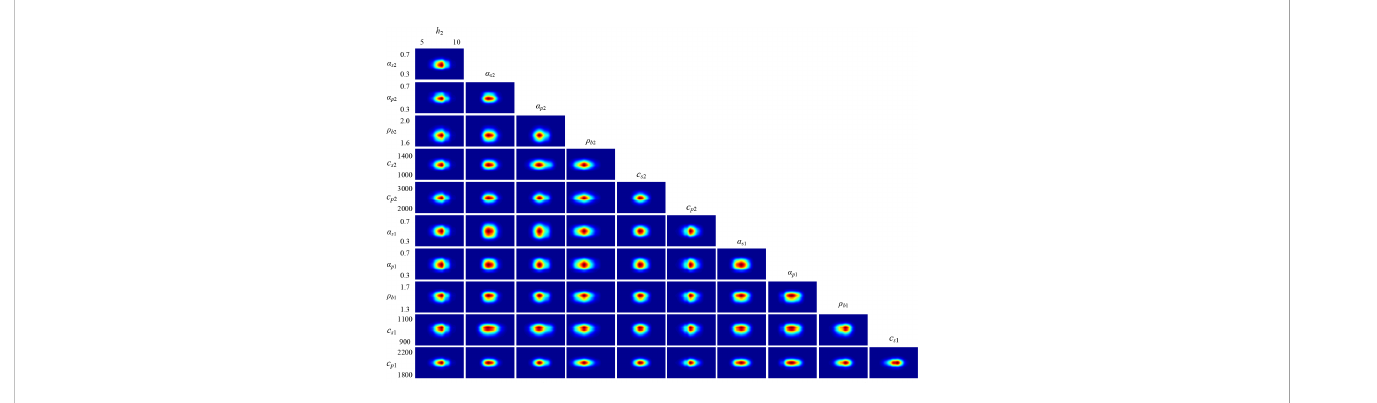
FIGURE 9 Two-dimensional joint marginal probability density distribution for 2-layer